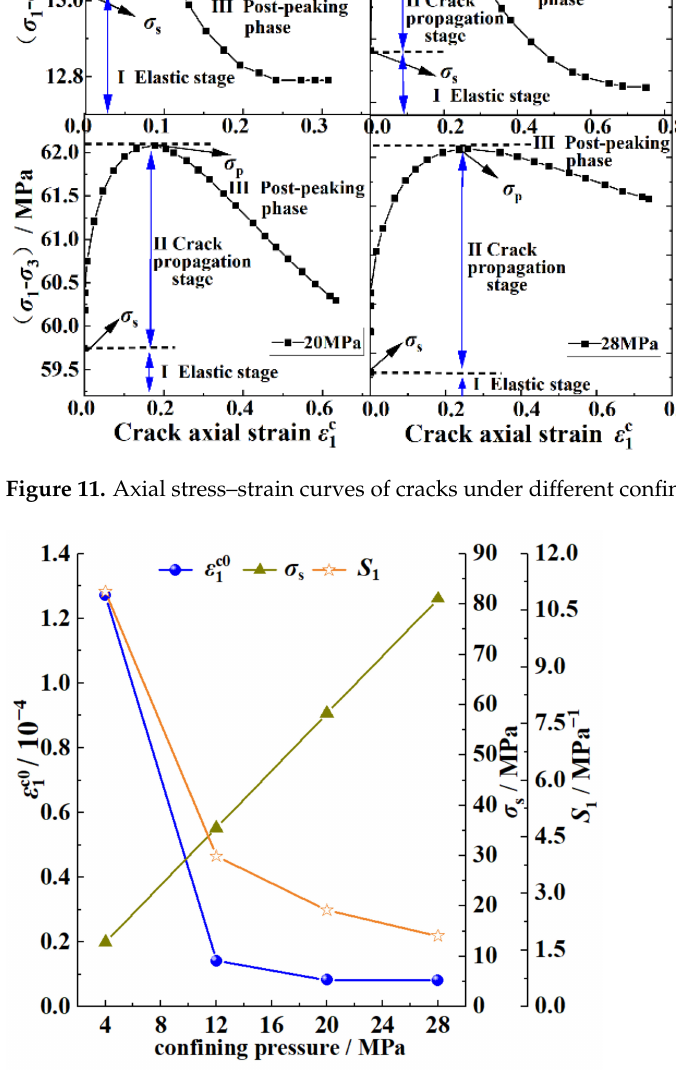
Figure 12. Curve of fitting parameters changing with confining pressure.